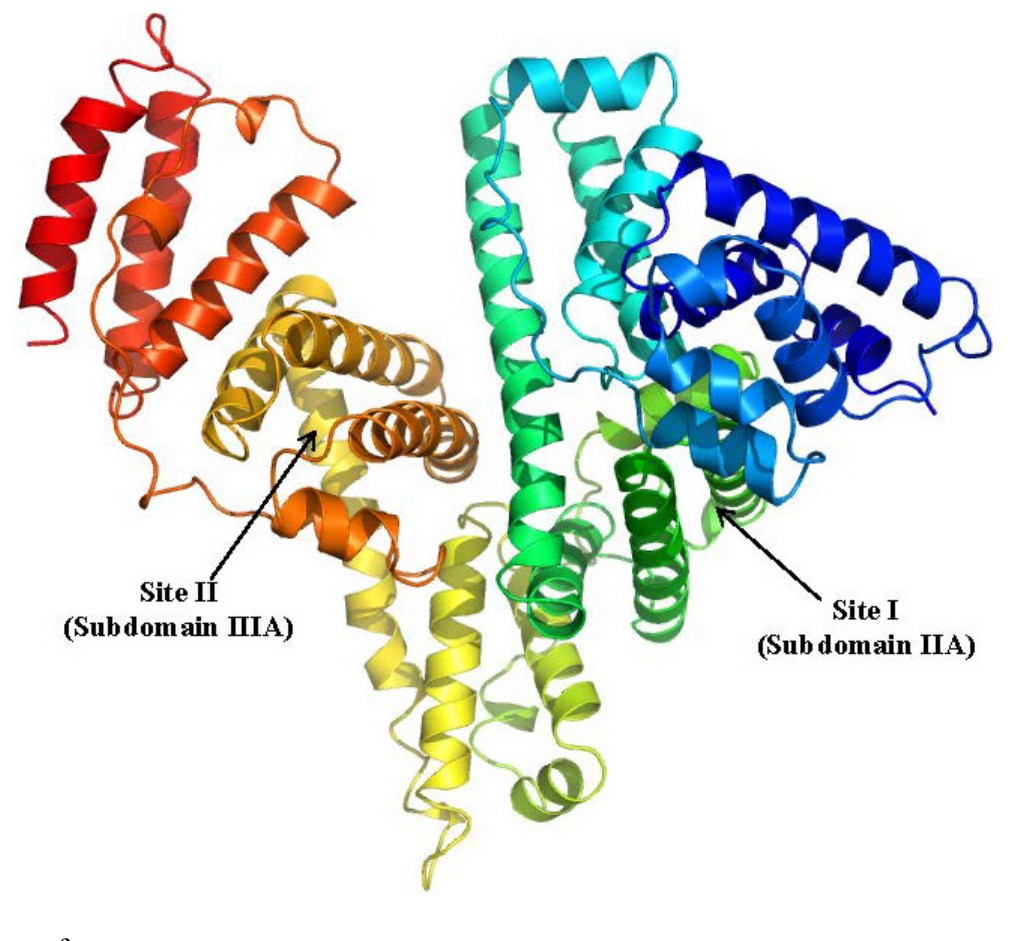
Figure 3. Crystal structures of the human serum albumin. The illustration was produced by PyMol using the atomic coordinates from Protein Data Bank, PDB2BXA